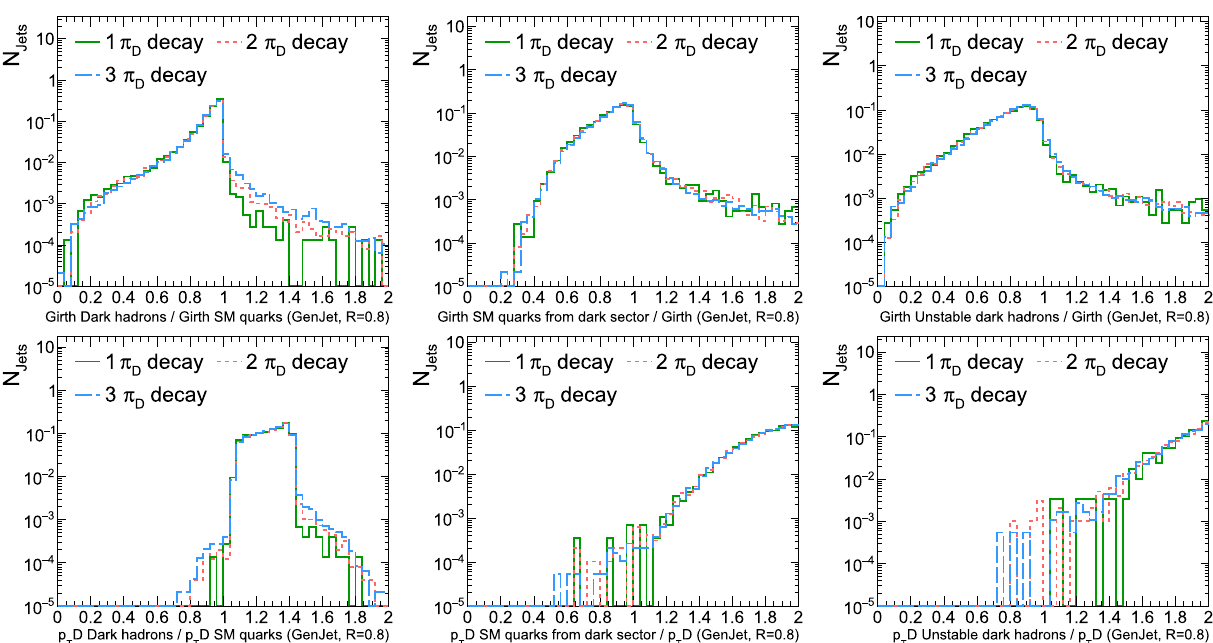
Fig. 45 Test of IRC safety. Ratio of jet substructure variables (top: girth, bottom: p T D ) computed at three different levels: unstable dark hadrons, SM quarks from dark hadrons and SM hadrons. Large variations are observed for p T D , which is IRC-unsafe, while ratios of girth, which is IRC-safe, peak at